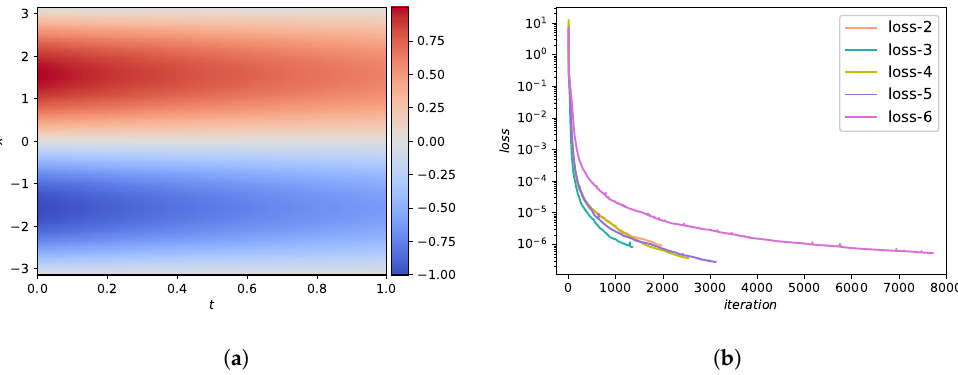
Figure 7. Results of Equation (28). ( a ) The predicted solution c ( t , x ) . ( b ) The change process of the objective function versus iteration number.